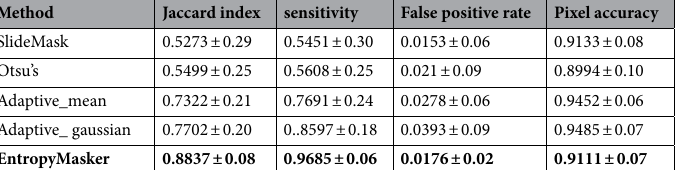
Figure 1. Schematic overview of the EntropyMasker method for masking whole-slide images. Atherosclerotic plaque tissue samples were collected from arterial endarterectomy surgeries, sectioned and mounted on tissue slides as part of the Athero-Express Biobank Study. The slides were subjected to histological staining for overall morphology (hematoxylin & eosin; HE), collagen deposition (Picrosirius red; SR), fibrin deposition (Fibrin), elastin fibers (Elastica Van Gieson; EVG) or immunohistochemical staining for cell-type specific markers: alpha- smooth muscle actin (a-SMA), macrophages (CD68), endothelial cells (CD34), or erythrocytes (glycophorin C). Whole-slide images of each slide were generated using high-resolution scanners and images were stored in a database (~ 25,000 images). Red, Green, Blue (RGB) color images were converted to grayscale images and grayscale pixels were used to calculate entropy threshold map for histogram analysis, and tissue segmentation was performed to create tissue mask of WSIs for subsequent data analysis and benchmarking. Schematic was created with